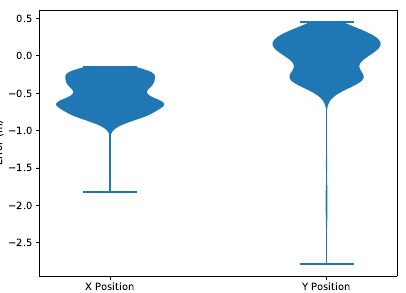
Figure 13. Violin plots showing the error distribution of the X and Y position state